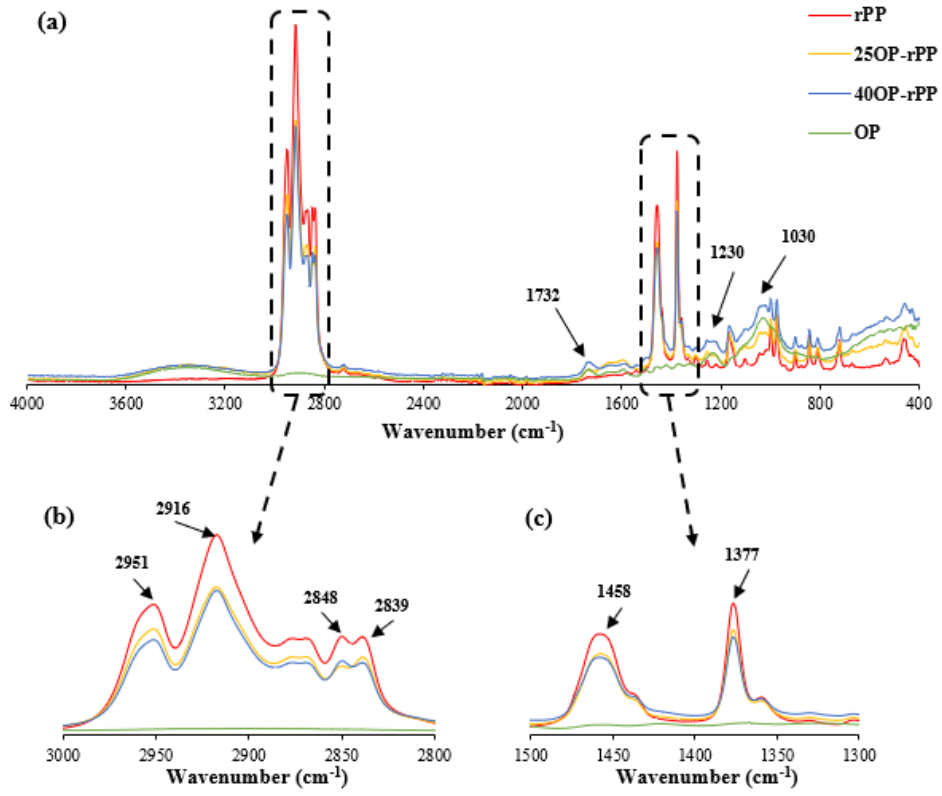
Figure 15. FT − IR Spectrum of rPP, OP and composites loaded with 25 and 40 wt% OP: ( a ) region: 400-4000 cm − 1 ; ( b ) region: 2800-300 cm − 1 ; ( c ) region: 1300–1500 cm − 1 .